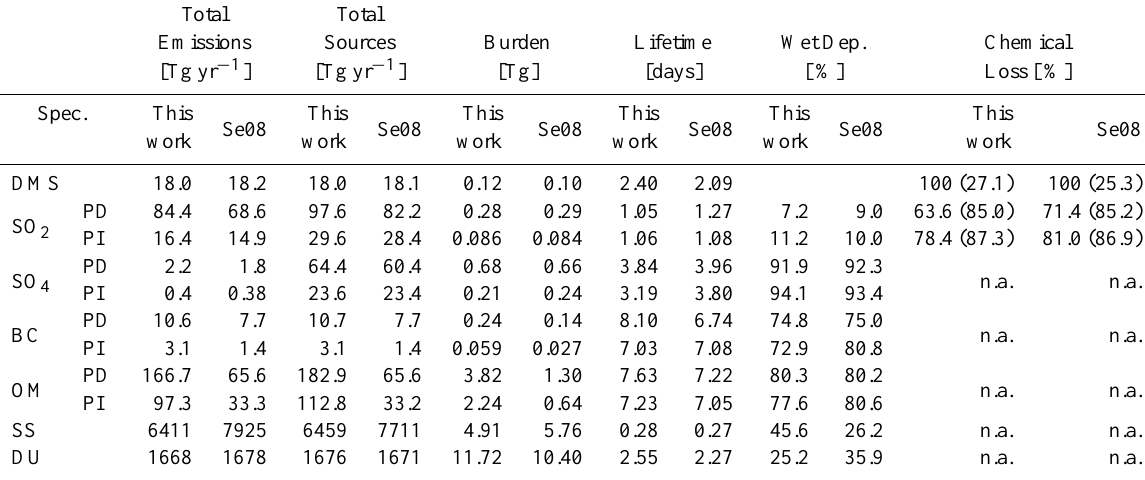
Table 3. Calculated global annual mass budget numbers for the individual modelled species in CAM4-Oslo (this work) and in Seland et al. (2008) (Se08). Simulation period: year 3–7. The upper values in a table cell are for present-day emissions, PD, and the lower for preindustrial emissions, PI. Emission years are 1850 (PI) and 2006 (PD) for CAM4-Oslo, and 1750 (PI) and 2000 (PD) for S2008. For DMS, SS, and DU, emissions are the same for PI and PD. For gaseous precursors, the fractions of chemical loss are also included. Numbers in parenthesis give the percentage of this loss, which respectively concerns gaseous oxidation of DMS to MSA, and aqueous-phase oxidation of SO 2 to sulphate. Sources and burdens of sulphur species are given as